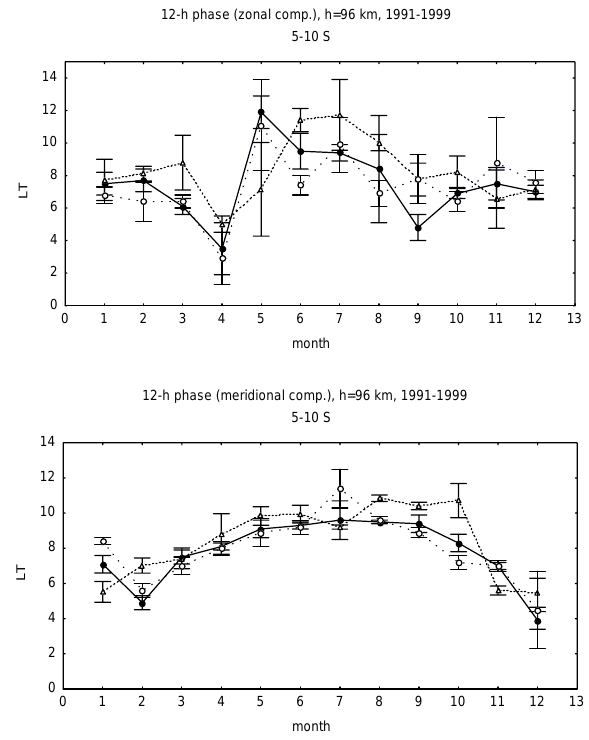
Fig. 20. Same as Fig. 16, except for phase of semidiurnal